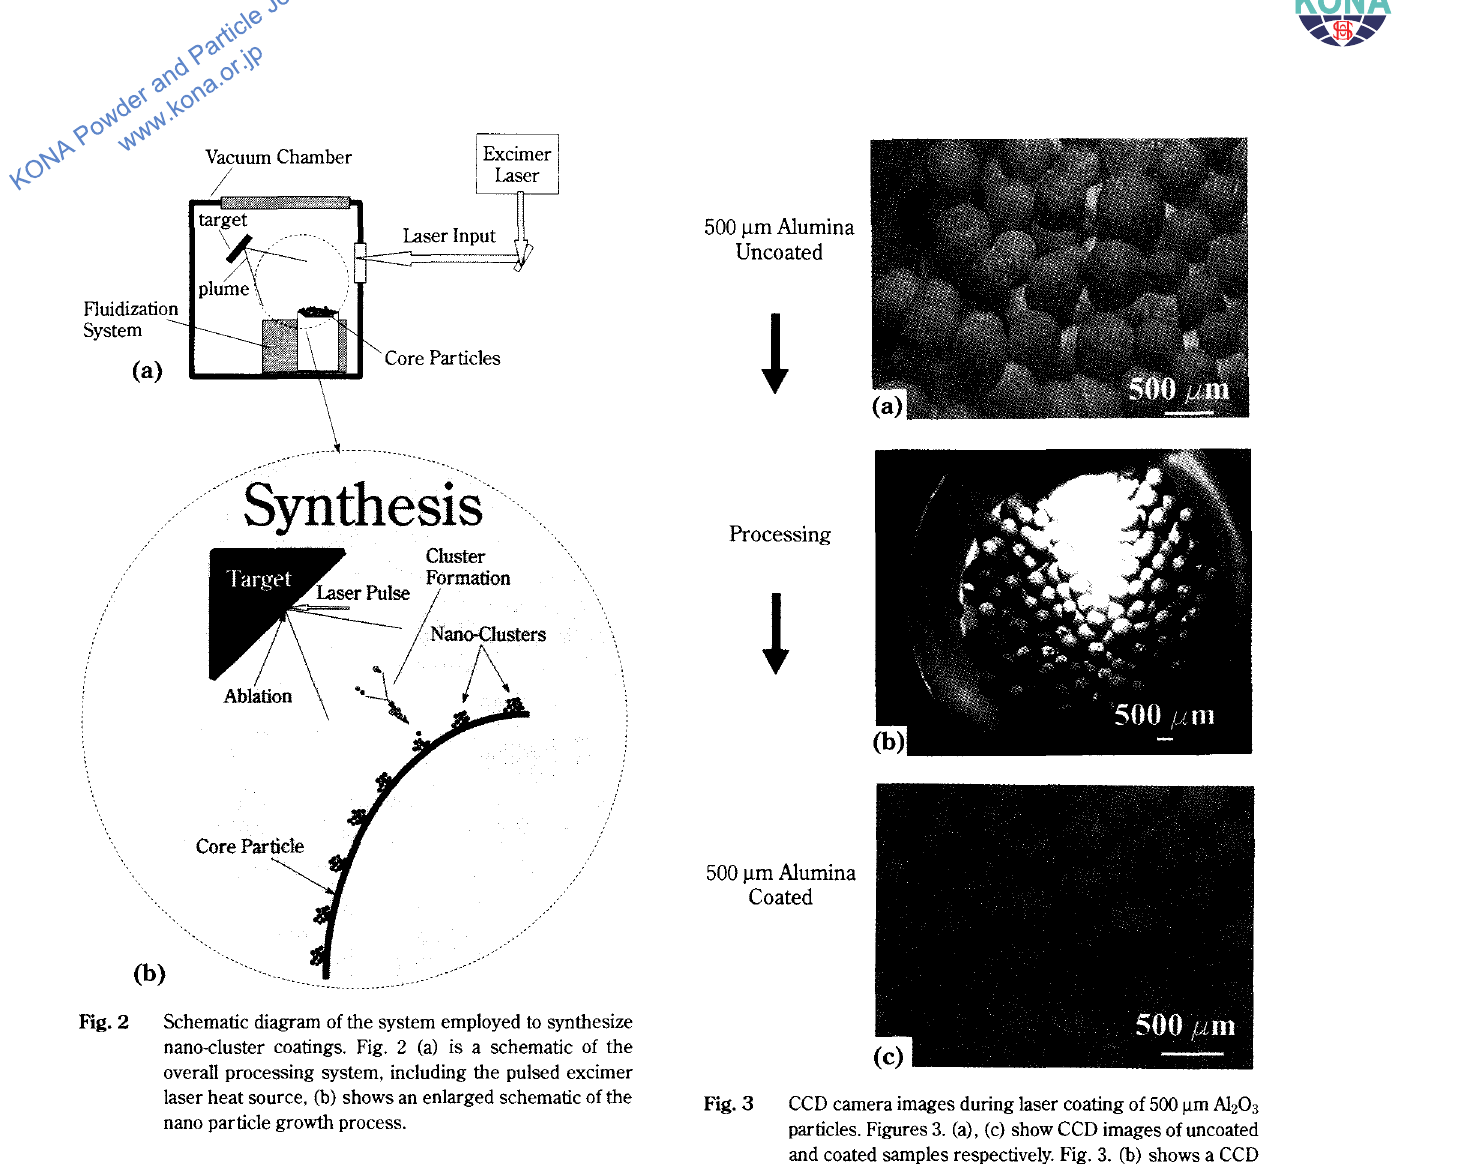
CCD camera images during laser coating of 500 Jlm A}z0 3 particles. Figures 3. (a), (c) show CCD images of uncoated and coated samples respectively. Fig. 3. (b) shows a CCD image during processing, where optical emission from the plume is clearly